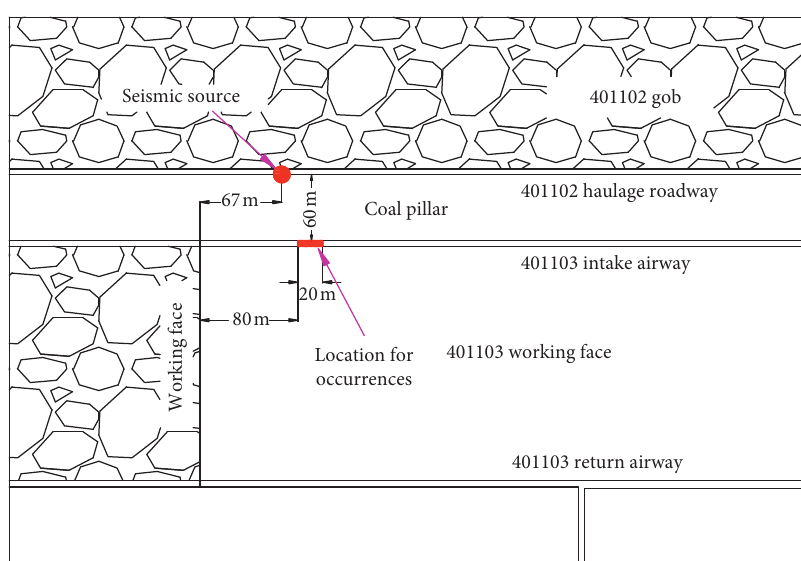
Figure 1: Location of seismic sources and occurrences of rock burst event at 23:15pm on June 17,